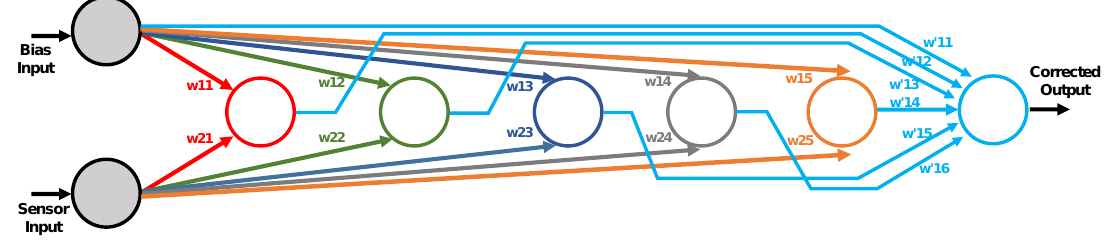
Figure 16. Weight definition of the neural network equivalent architecture.